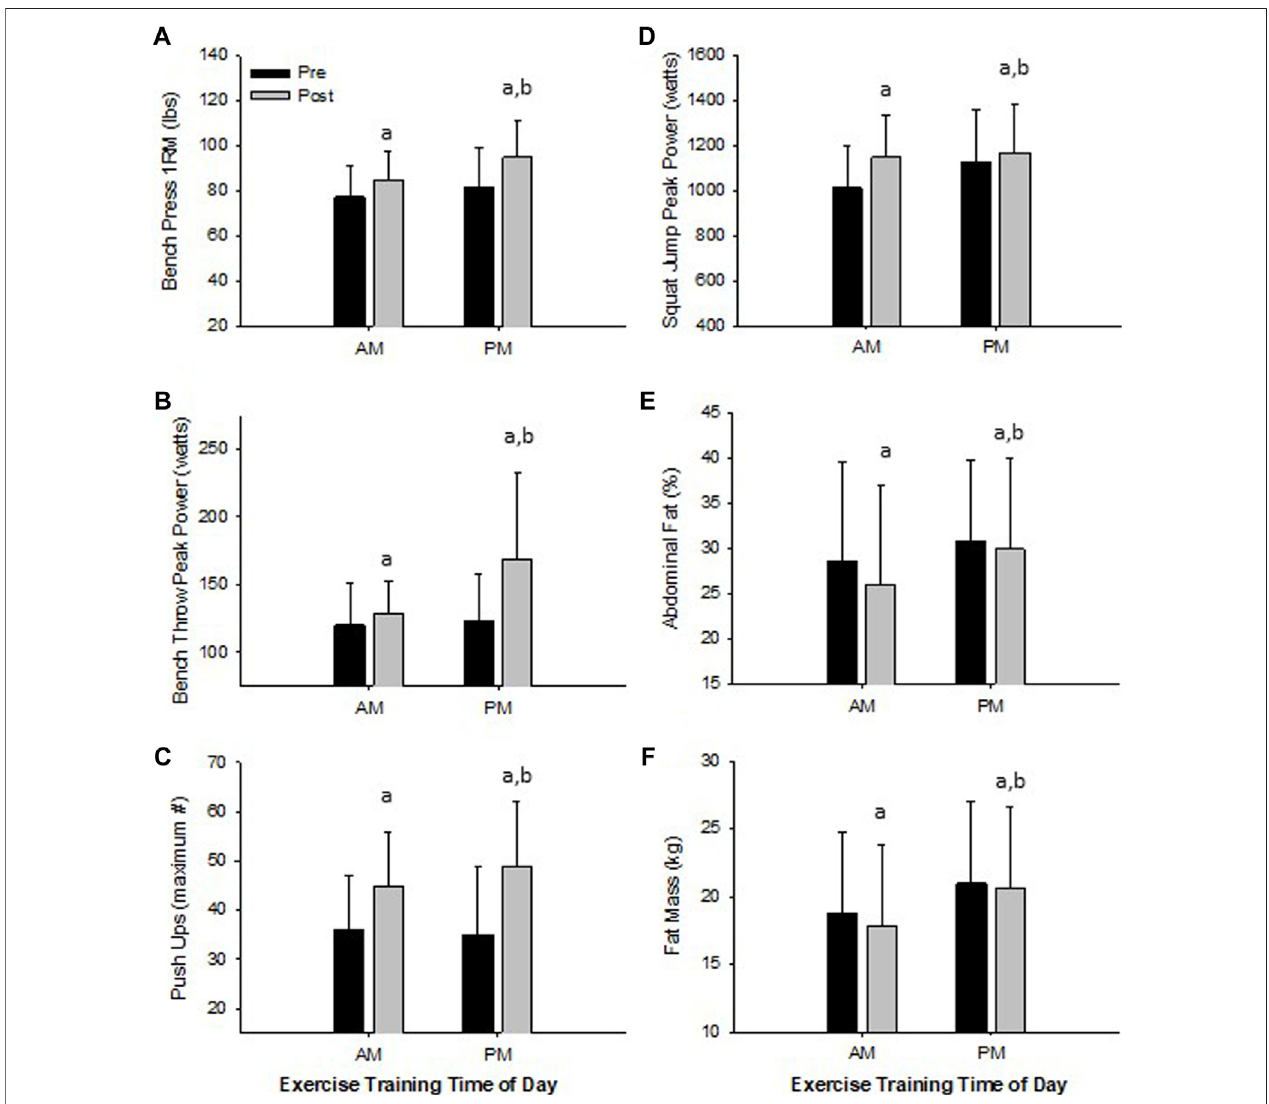
FIGURE3| Signi fi cantChanges in Womenwith RISE Exercise Training Conducted inthe Morning (AM)or Evening (PM). Upper BodyMaximal Strength (A) , Upper Body Peak Power (B) , Upper Body Muscle Strength/Endurance (C) , Lower Body Peak Power (D) , Abdominal Fat Percent (E) , and Fat Mass (F) . a p < 0.05 pre vs post pairwise differences; b p < 0.05 group × time interaction. Data are means ±